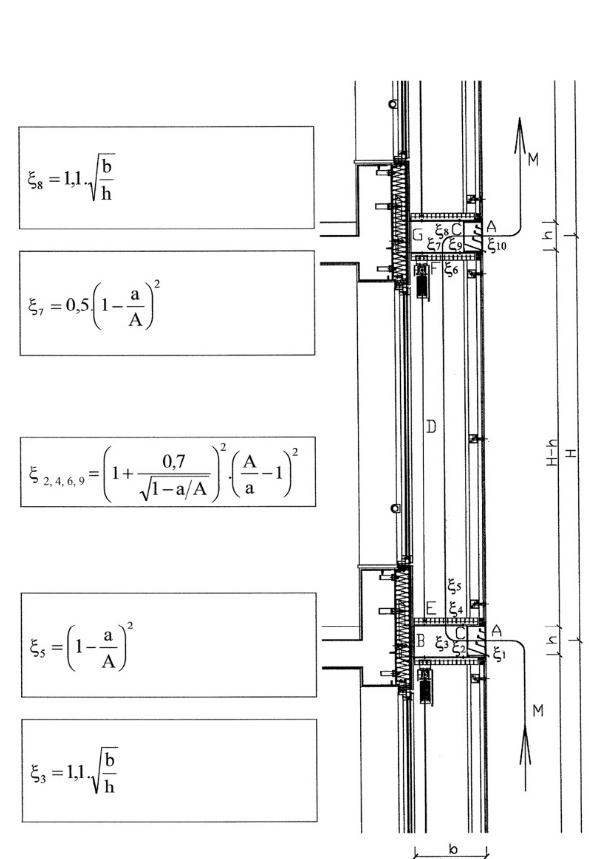
Figure 5: Aerodynamic coeflcients of local resistances ξ 2 , ξ 3 , ξ 4 , ξ 5 , ξ 6 , ξ 7 , ξ 8 , ξ 9 (-) in the trajectory of air flow (a – net area opening for air movement, A – total area of the air inlets including its solid parts, b – planar width of the rectangular cross-section, h – height of rectangular cross